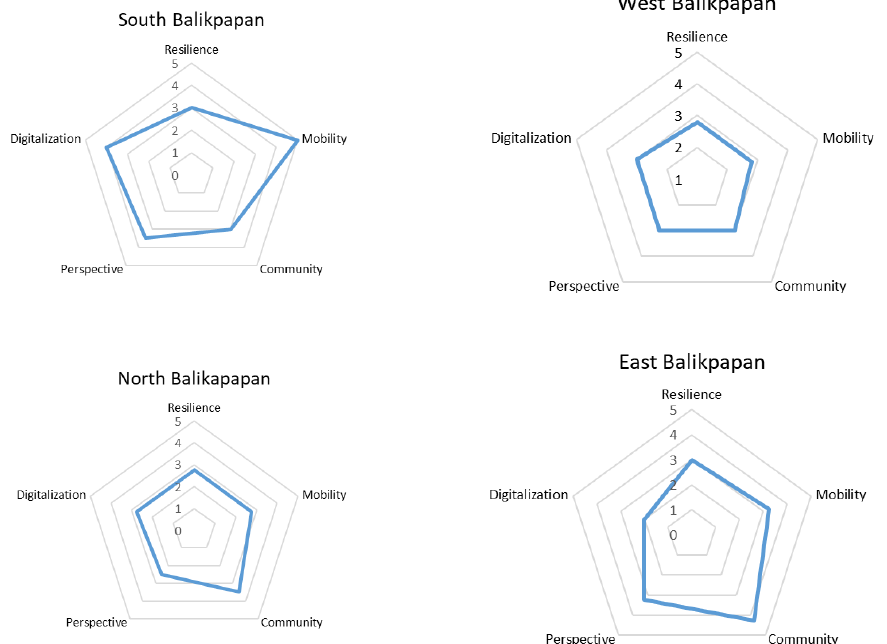
Figure 6. Smart Village Current Condition During COVID-19 in Balikpapan (source: authors analy- sis).